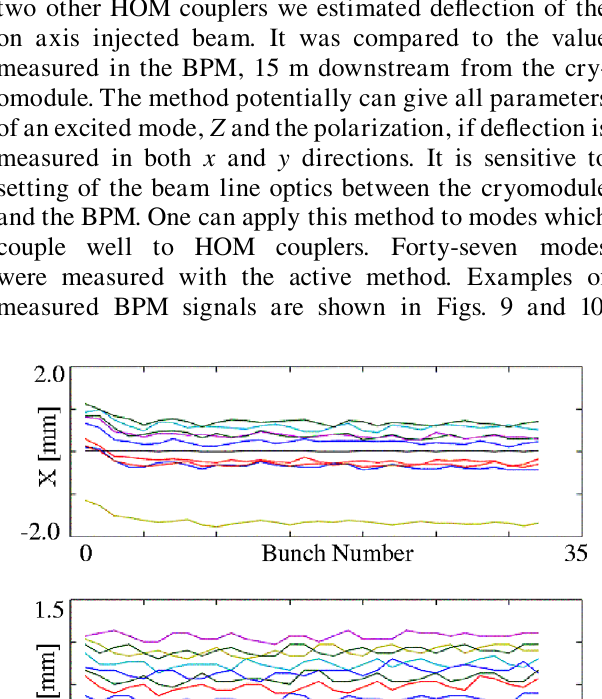
figure are normalized: (cid:7) A (cid:4) h A i(cid:10) = h A i . They showed the